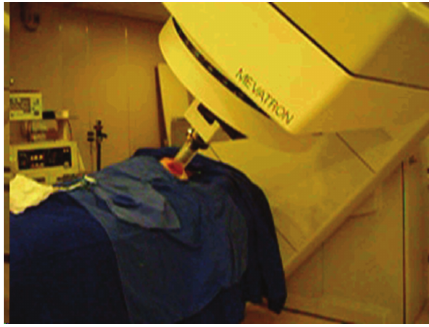
Figure 2: Intraoperative irradiation.